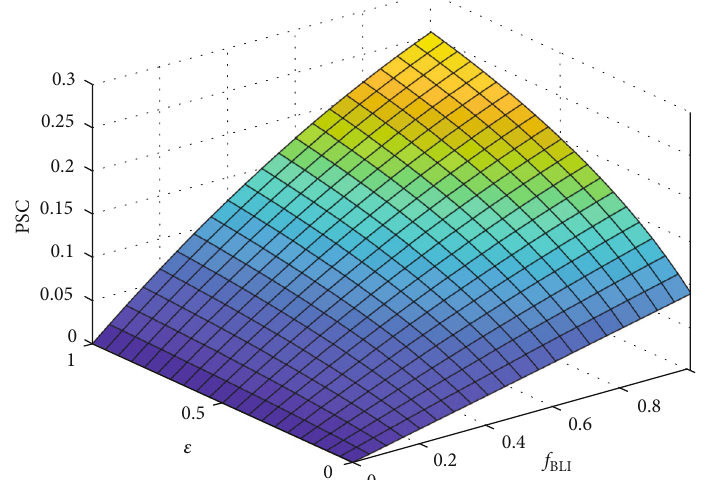
Figure 3: The variation of PSC with f